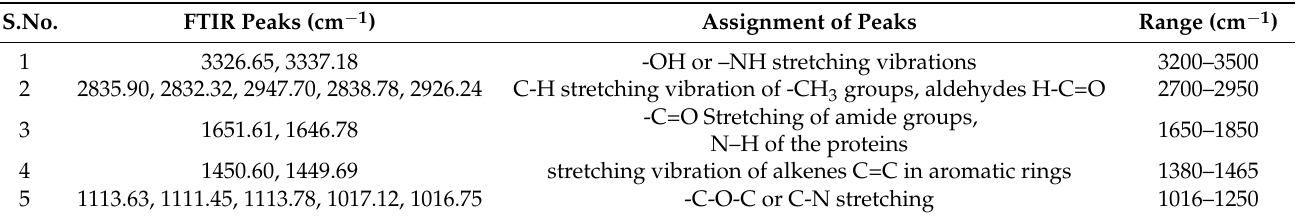
Figure 7. Schematic representation of reduction of Methylene Blue (MB).